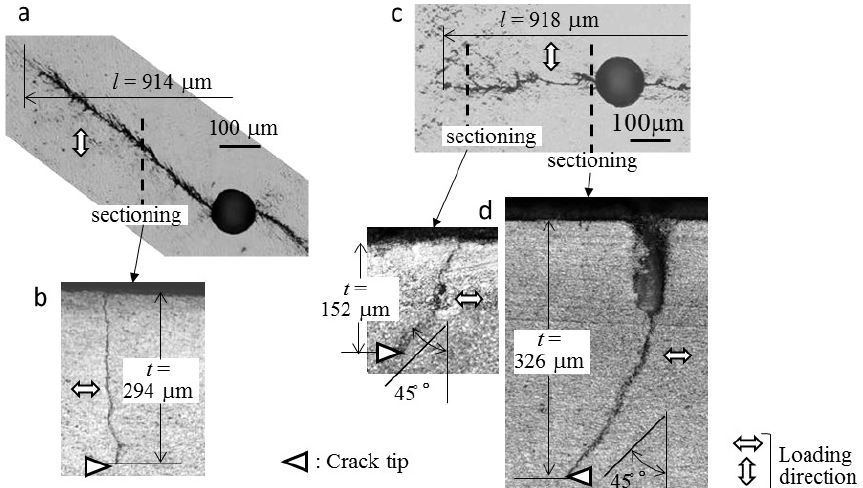
Figure 4: Crack paths at  a = 240 MPa: (a and c) sectioning position described in the crack paths of the zx - and xy -planes; (b and d) crack paths in the sectioned plane for the zx - and xy -plane